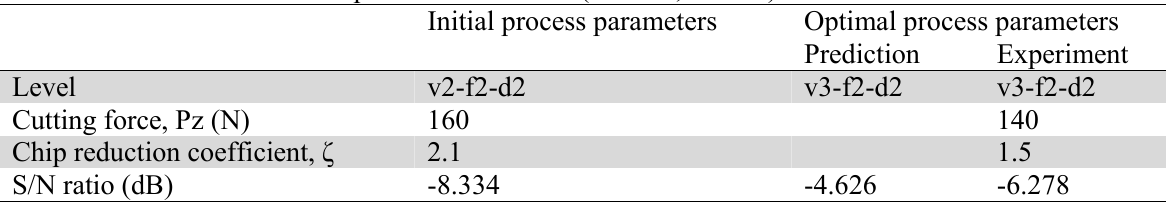
Results of the confirmation experiment for case-3 (w 1 = 5, w2 = 5) Initial process